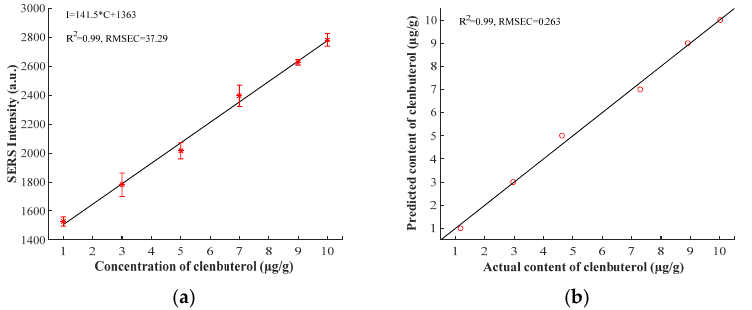
Figure 7. ( a ) The relationship between Raman intensity and clenbuterol content of samples. ( b ) The plot of the clenbuterol content of samples determined by SERS versus the actual clenbuterol content of samples.